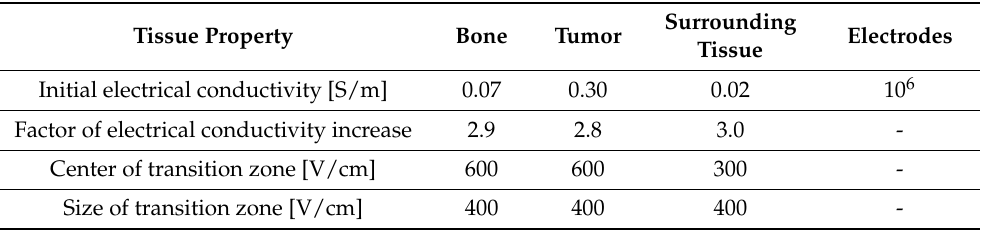
Surrounding Electrodes Tissue